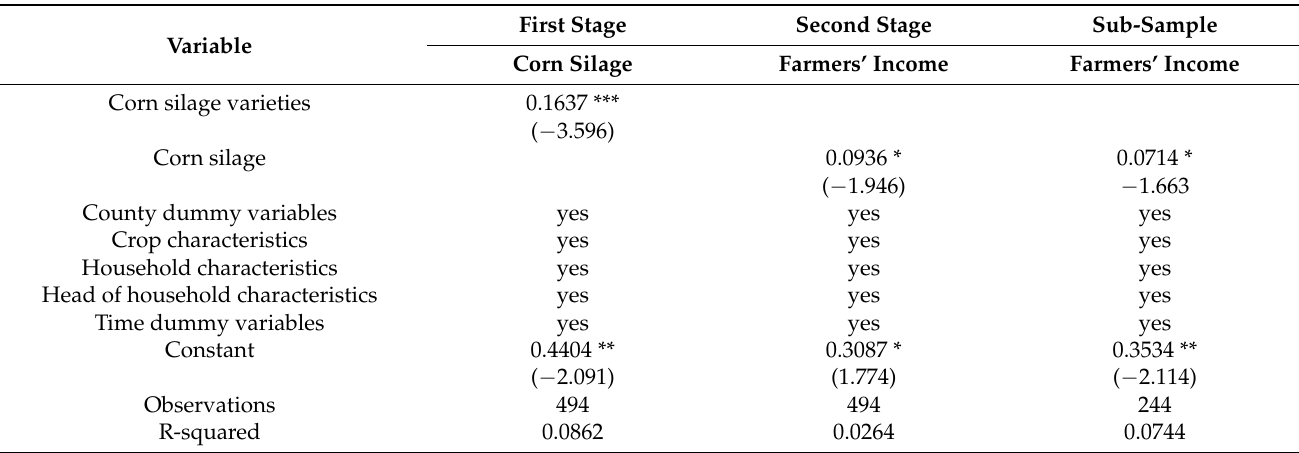
Table 3. The estimation results using instrumental variable and sub-sample methods for